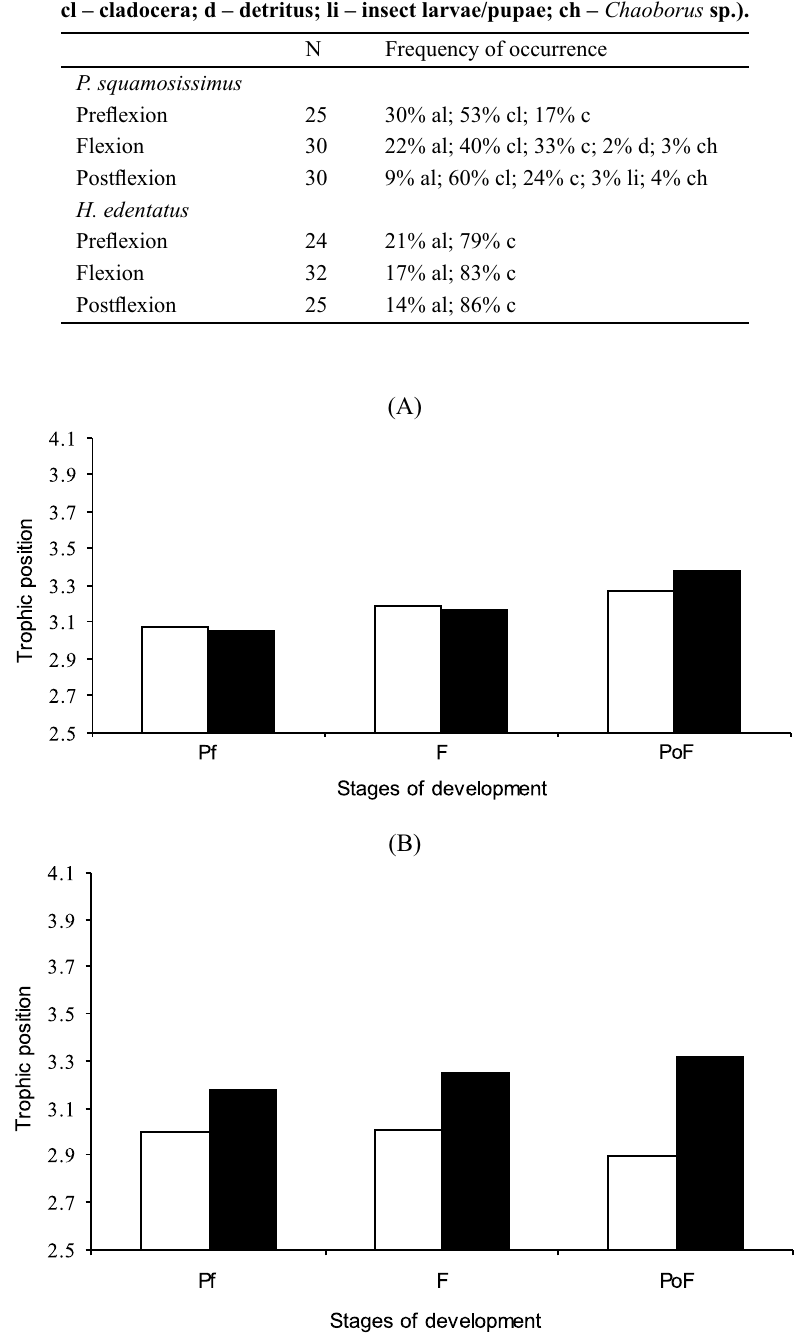
Fig. 3 – Trophic position calculated using nitrogen isotope value ( (cid:3) ) and diet ( (cid:4) ) during the preflexion (Pf), flexion (F) and postflexion (Pof) stages of Plagioscion squamosissimus (A) and Hypophthalmus edentatus (B) larval